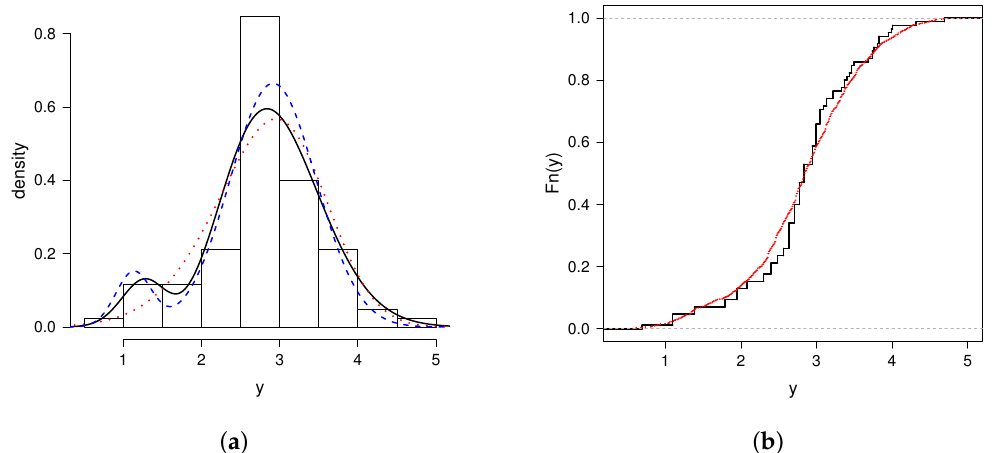
Figure 5. Fitted densities: ( a ) SN (dotted red line), MN (dashed blue line) and BESN (solid black line), ( b ) Empirical cdf (solid black line) and BESN distribution (dashed red